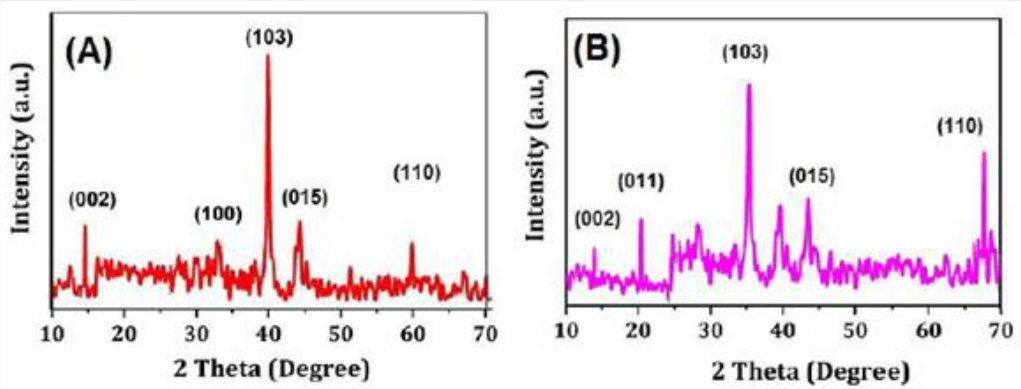
Figure 2. PANI–MoS 2 after Hg(II) adsorption ( A ) FESEM image ( B ) EDX spectra.